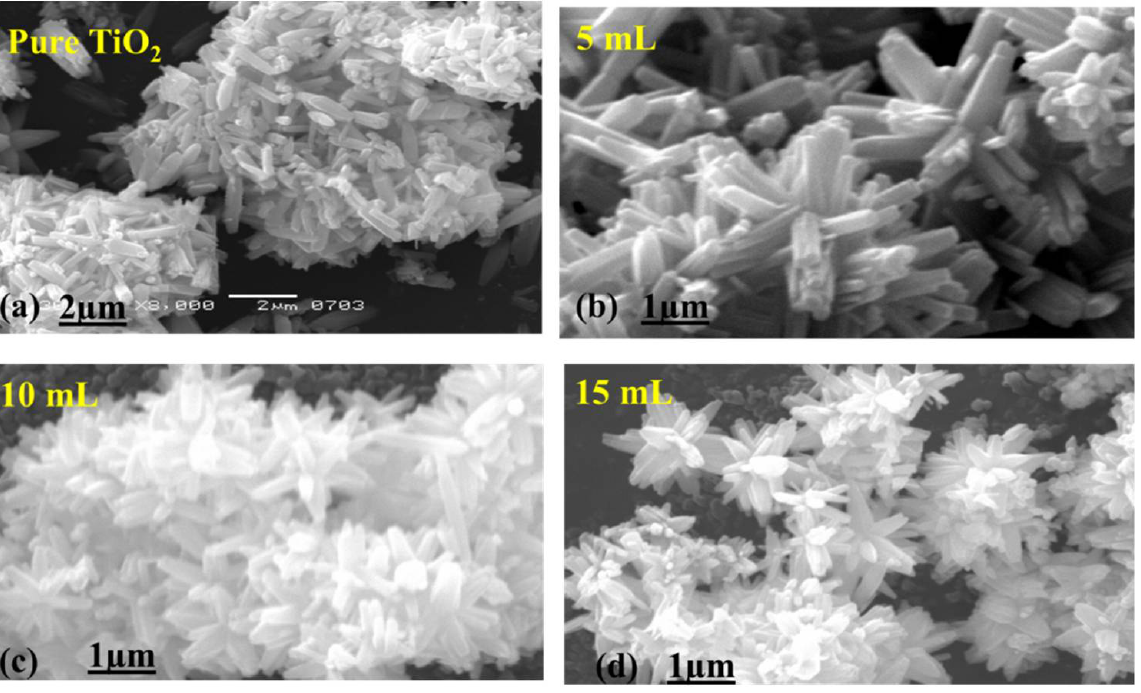
Figure 1. SEM images of bulk TiO 2 that has been hydrothermally treated ( a ) and treated with 5, 10, and 15 mL of FC leaf extracts ( b – d ).